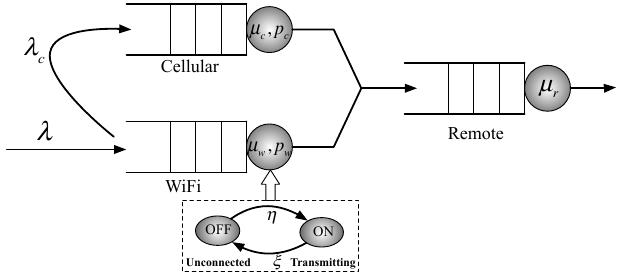
Figure 5: Full offloading model with cellular and WiFi networks